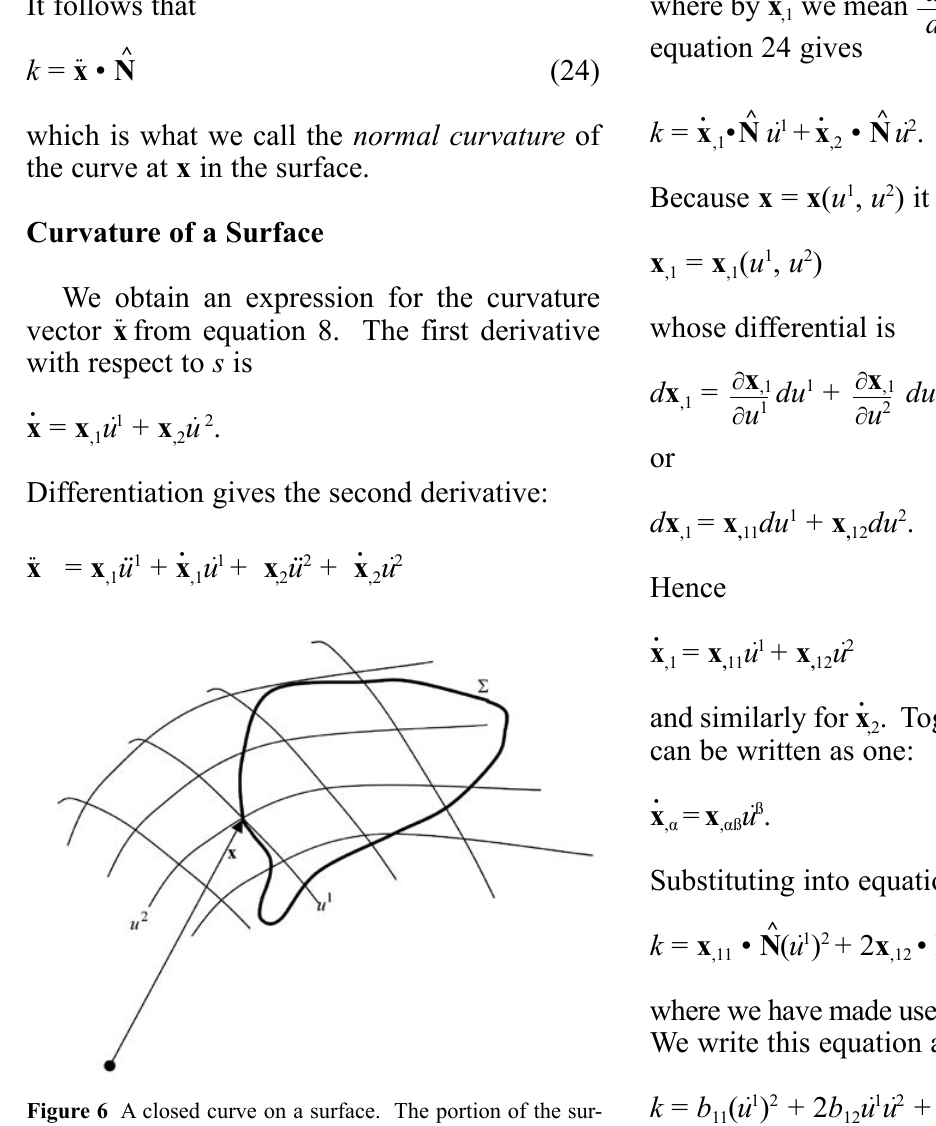
. The area of that portion 